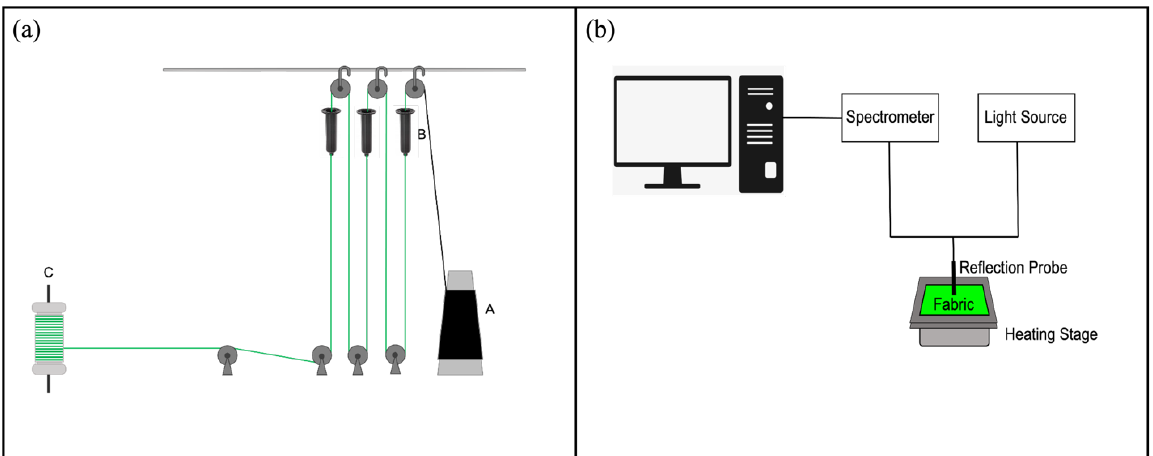
Figure 1. Schematics of ( a ) Yarn Coating Apparatus and ( b ) Reflectance Measurements. In ( a ), the bare yarn (A) is looped through pulleys and ink barrels (B), then dried before it is collected in the motorized spool (C). The measurements in ( b ) were made using a fiberoptic-based UV-VIS spectrometer consisting of reflection probe, light source and detector. Data was taken at various temperatures controlled by placing the fabric on a heating stage.